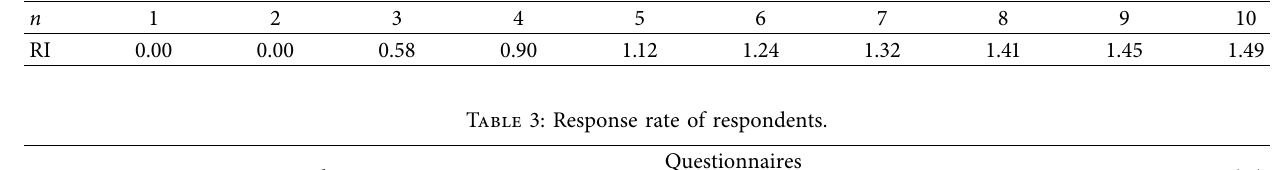
Table 2: RCI values for diferent values of n [24].